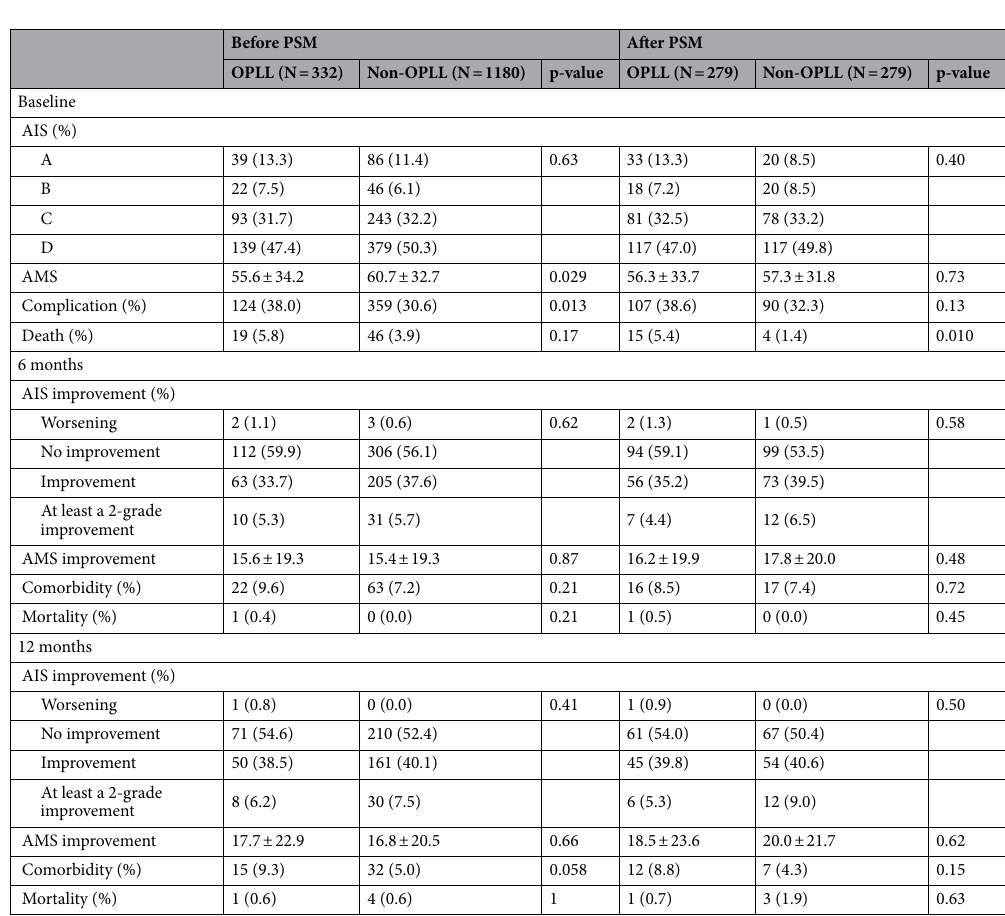
Table 4. A comparison of the primary and secondary outcomes between the OPLL and non-OPLL groups. PSM, propensity score matching; OPLL, ossification of the posterior longitudinal ligament; AIS, American Spine Injury Association impairment scale; and AMS, American Spine Injury Association motor